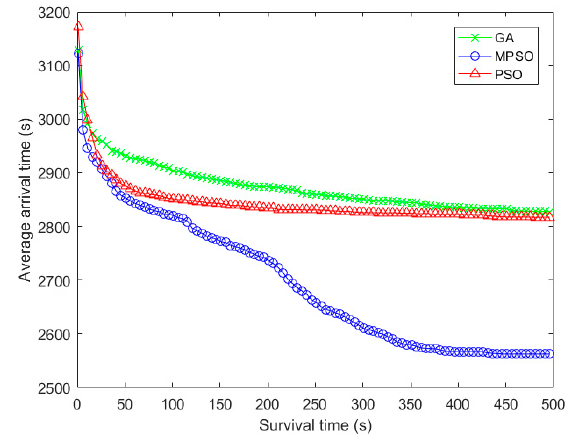
Figure 11. Comparison of average arrival time with the iteration times.